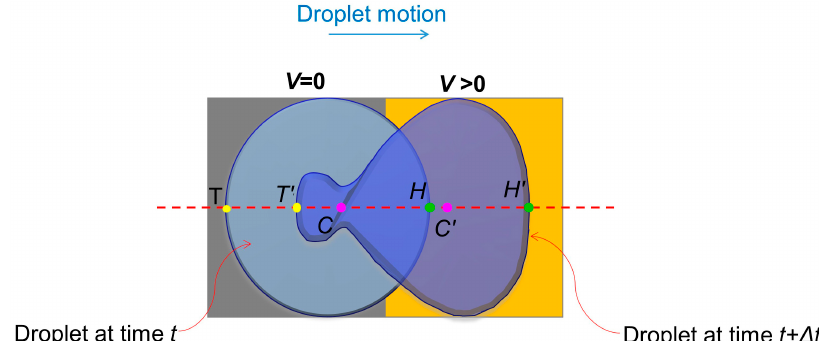
Figure 3. Measuring average velocity of a dynamic droplet. The droplet at left-hand side represents a droplet at any time instant, t , during transition from grounded electrode to activated electrode. The droplet at the right-hand side is the same droplet after time interval, Δ t . T , T ′, H , H ′, C and C ′ denote three points designated as the droplet head, tail and centroid at two different time instants, respectively. The orange surface is the activated electrode. The red dashed line is the horizontal axis in the droplet.